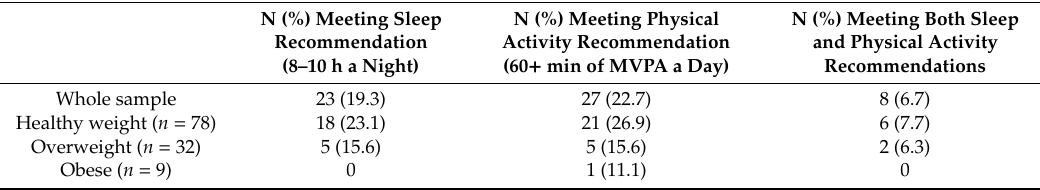
Table 2. Numbers of participants meeting the sleep and physical activity guidelines by weight